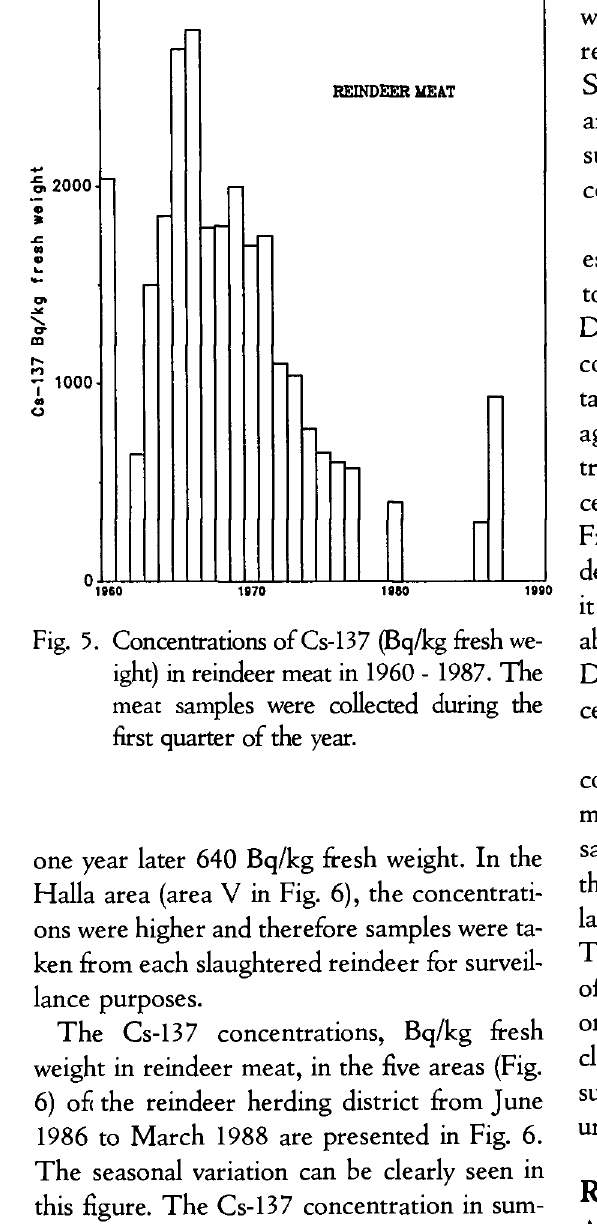
Fig. 5. Concentrations of Cs-137 (Bq/kg fresh we ight) in reindeer meat in 1960 - 1987. The meat samples were collected during the first quarter of the